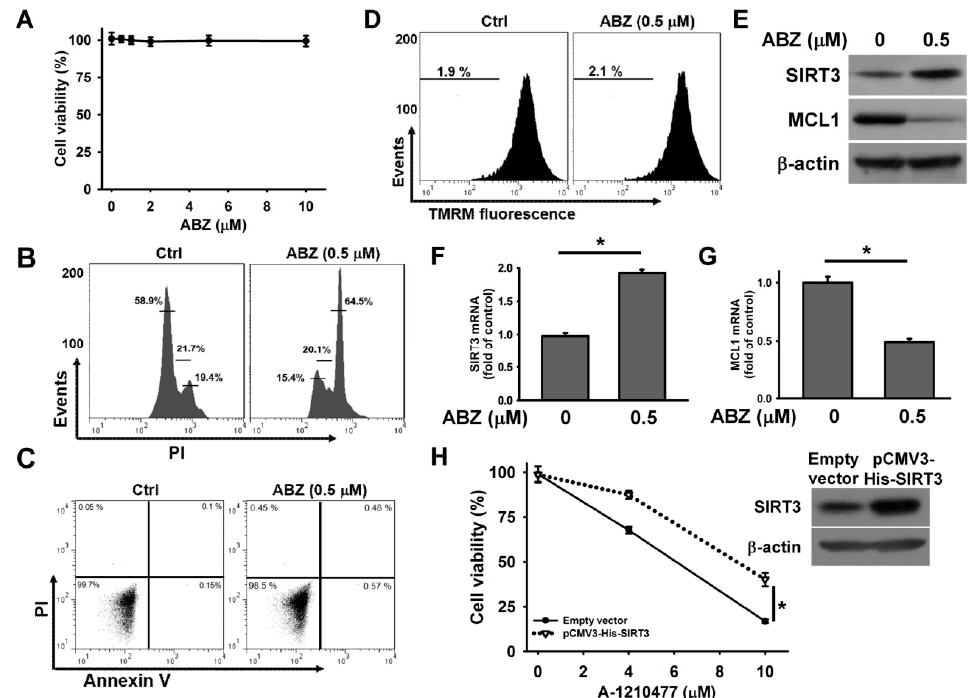
Figure 7. SIRT3 upregulation protected MEG-01 cells from the cytotoxicity of ABZ-induced MCL1 downregulation. Without specific indication, MEG-01 cells were treated with 0.5 μ M ABZ for 24 h. ( A ) Concentration-dependent effect of ABZ on cell viability. MEG-01 cells were incubated with indicated ABZ concentrations for 24 h. Cell viability was determined using MTT assay. ( B ) Cell cycle analysis of ABZ-treated MEG-01 cells. ( C ) Flow cytometry analyses of annexin V-PI double staining of ABZ-treated cells. ( D ) Effect of ABZ on ΔΨ m in ABZ-treated cells. ( E ) Western blot analyses of SIRT3 and MCL1 expression in ABZ-treated cells. Analysis of ( F ) SIRT3 mRNA and ( G ) MCL1 mRNA levels in ABZ-treated cells (mean ± SD, * P < 0.05). ( H ) SIRT3 overexpression increased the viability of A- 1210477-treated MEG-01 cells. After transfection with an empty vector or pCMV3-His-SIRT3 for 24 h,